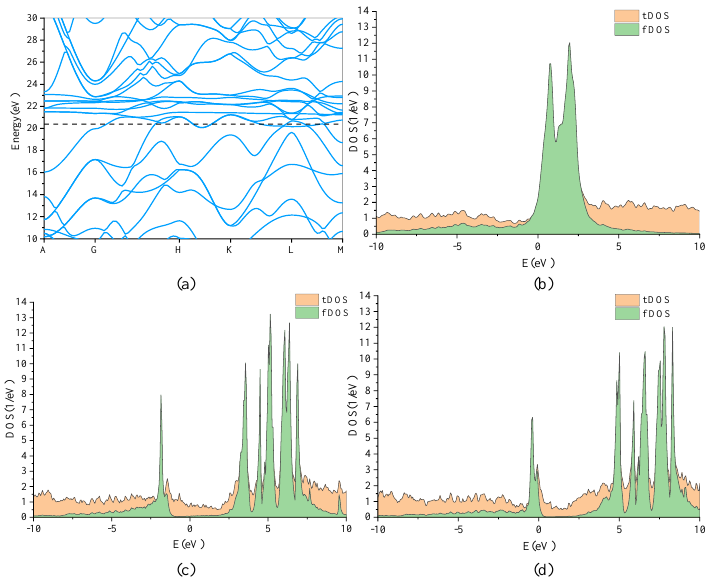
Figure 4. Spectral weight transfer induced by many-body corrections. ( a ) Electronic band structure and ( b ) density of states obtained by DFT calculations. tDOS and f DOS denote the spectral weight obtained by the imaginary part of respectively the lattice and f impurity Green function, correspond- ing to the spectral weight traced over all orbitals and traced over the f orbitals, respectively. In ( c , d ), we show the energy-resolved spectral weight, obtained respectively by the one-shot DFT+DMFT and the full-charge self-consistent DFT+DMFT+CSC. All calculations were performed in the P6/mmm phase of CeH 16 at 250